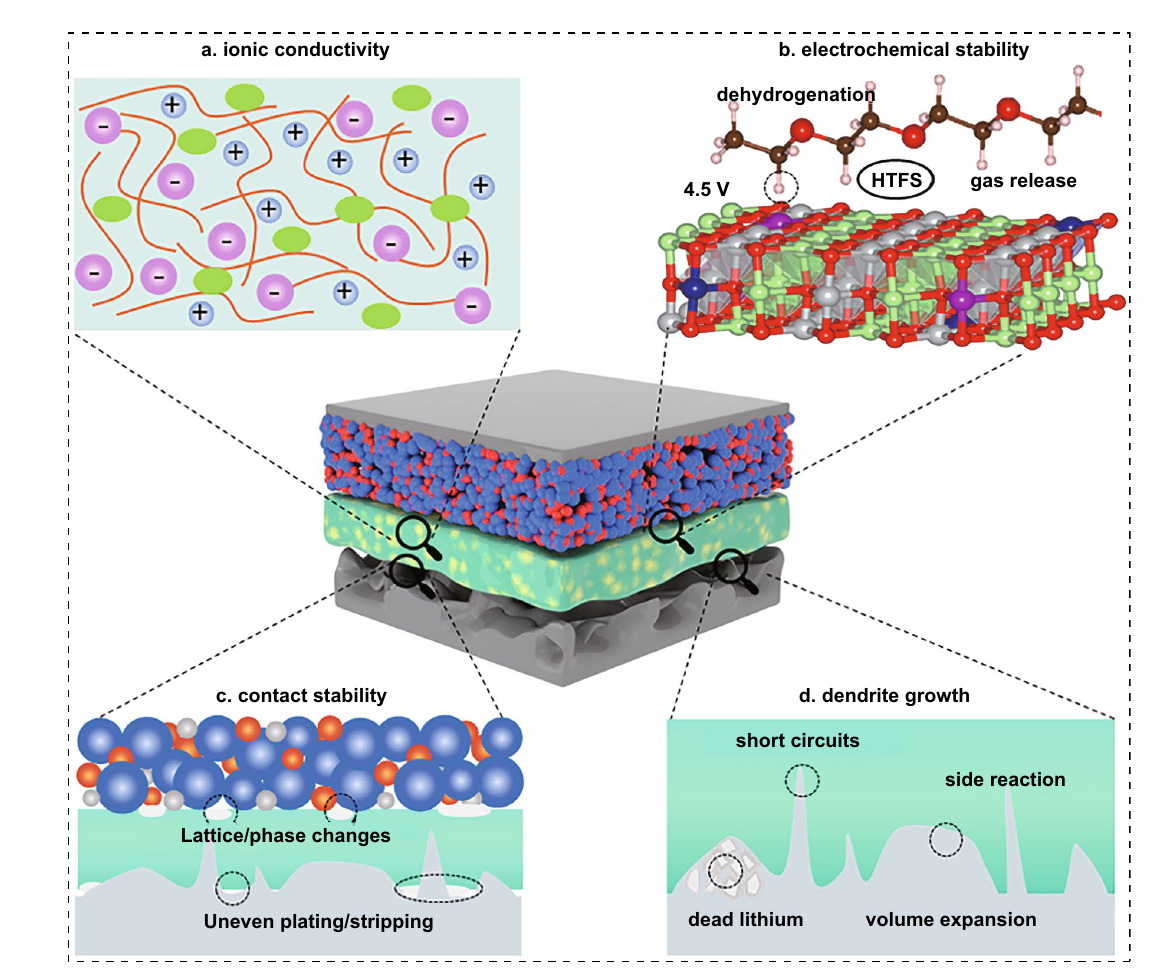
Fig. 2 Key issues in the development of